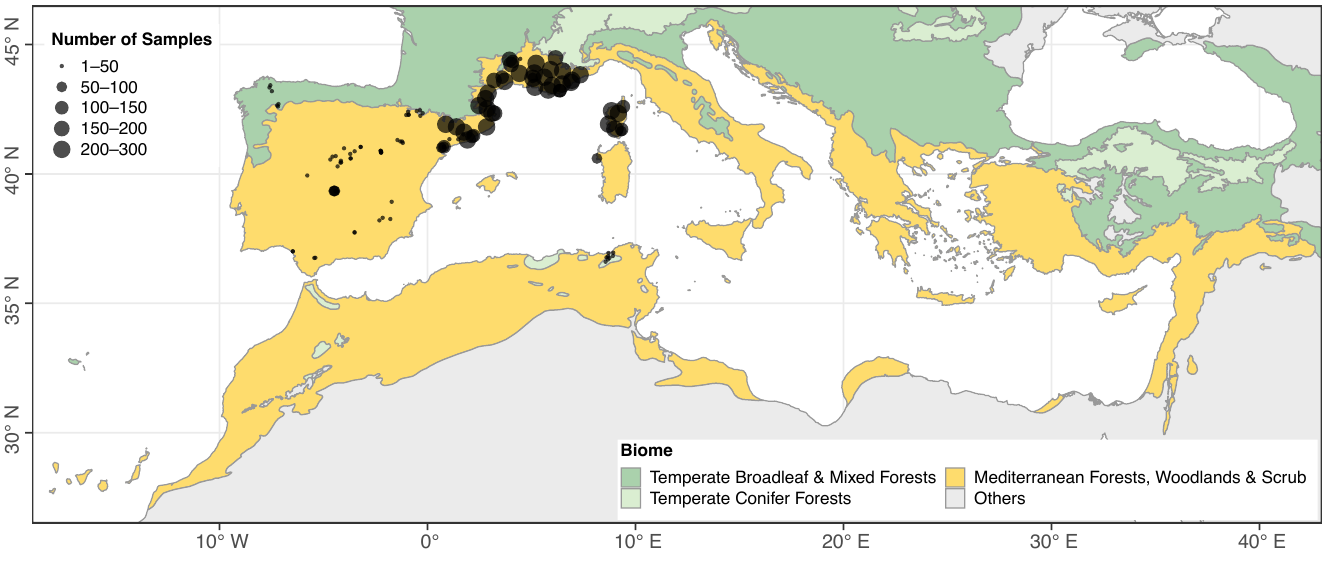
Figure 2. Distribution of sampling sites and extension of the mapping area for the database and future map productions. The background layer represents terrestrial biomes based on [44]. Gray areas were discarded from map